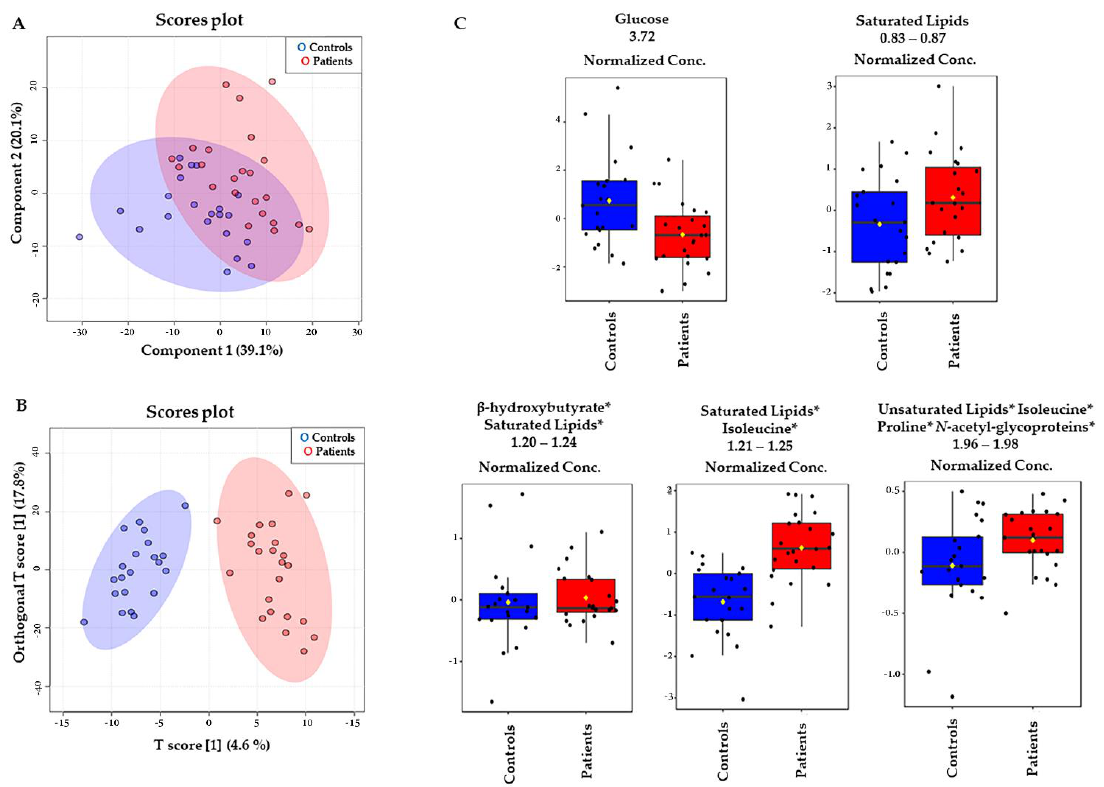
Figure 2. Multivariate analysis of 1 H-NMR (CPMG) plasma spectra. ( A ) PLS-DA results with the accuracy of 76%, R2 0.83, and Q2 0.23. ( B ) O-PLS-DA results. The information about response to treatment with ASM in patients with MTLE was not implemented into the models. ( C ) Box plots representing the variations of the relative concentrations (measured as peak intensities) of metabo- lites whose VIP scores > 2 according to PLS-DA results. The black dots represent the metabolite levels in all samples, and the yellow diamond represents the average value. Patients with MTLE (red) and controls (blue). * = overlaid signals. Table 2. Table showing the metabolites identified in different concentrations and their respective chemical shifts elucidated by the highest VIP values (VIP score). The p -values, calculated from the t-test, FC (fold change), and false discovery rate (FDR) are also shown. MTLE versus Control — VIP Score Metabolites Chemical Shift (Multip; Assign.) Vip Score